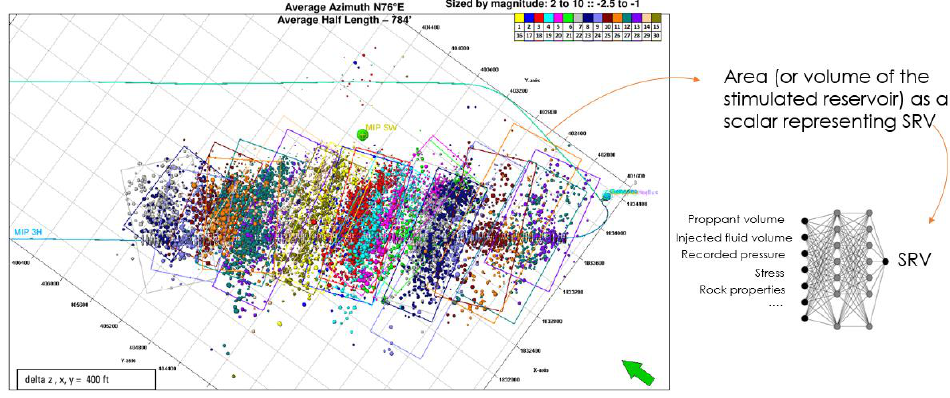
Figure 4. The conceptual workflow of estimating SRV in this study.